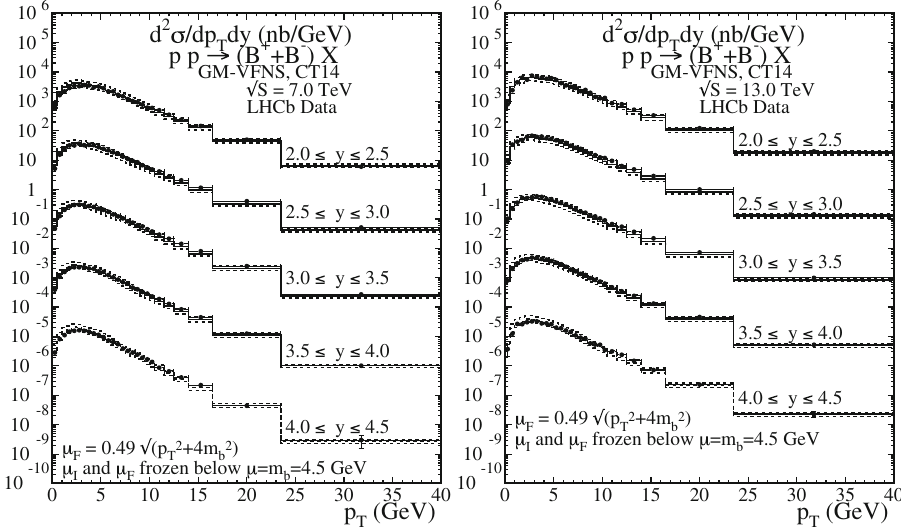
d 2 /dp dy (nb/GeV) T p